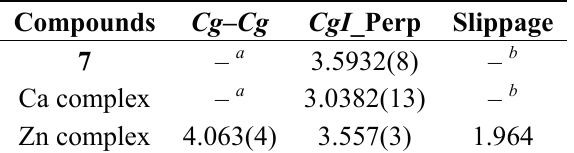
Table 3. Comparison of π - π interactions (Å).